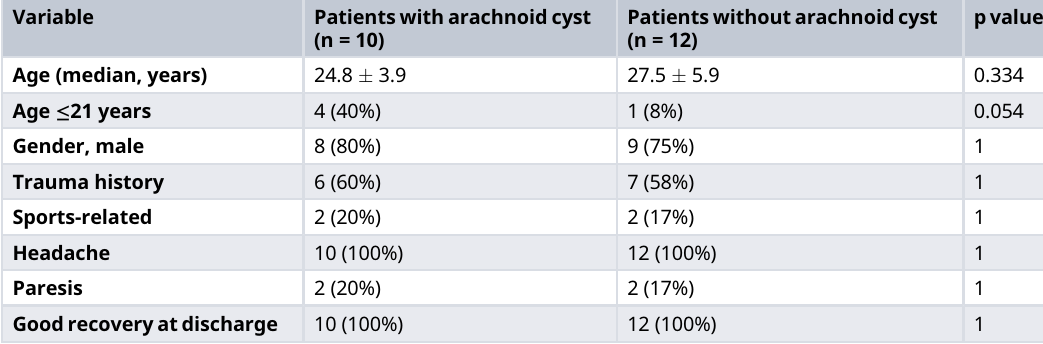
Table 2. Clinical features and neuroimaging study findings in 10 patients with arachnoid cysts and concomitant chronic subdural